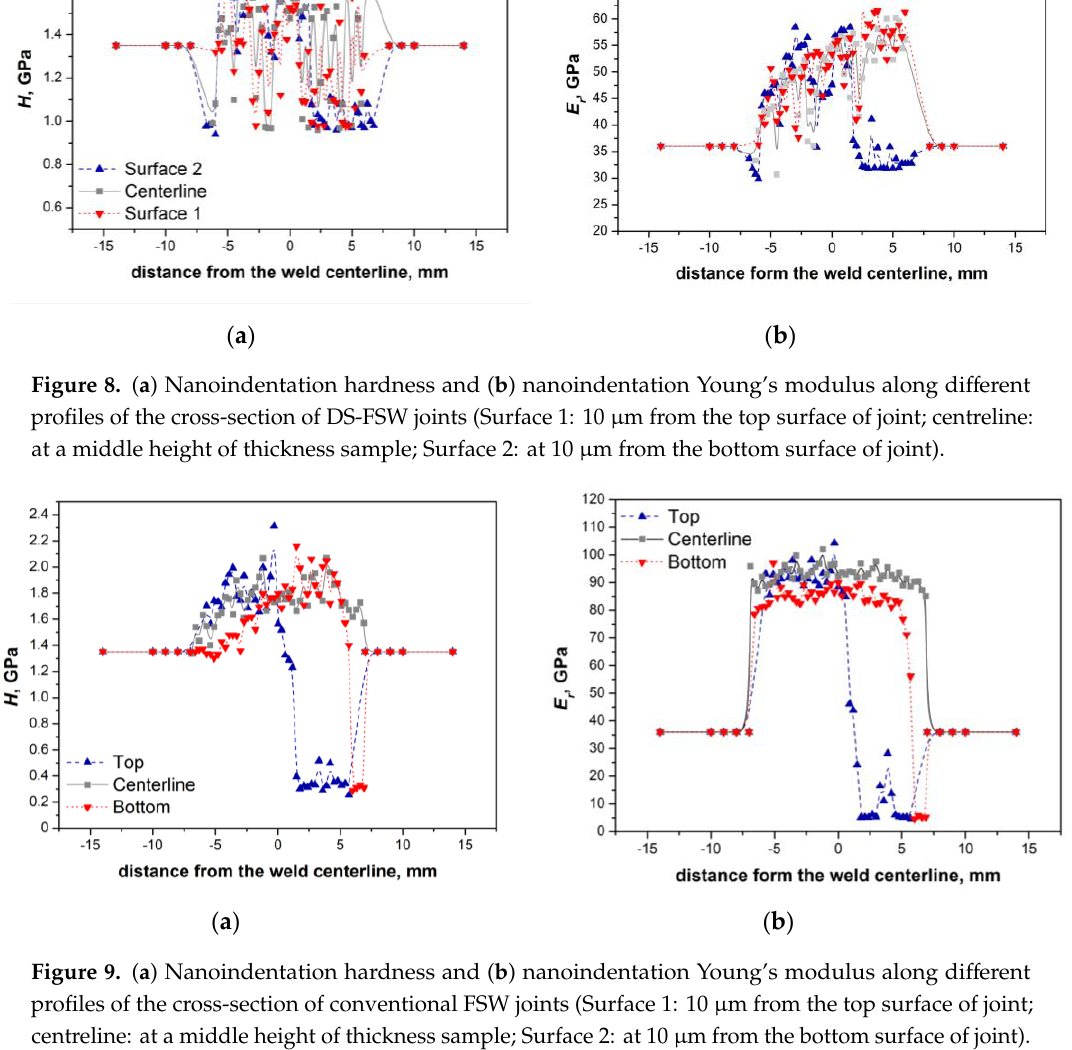
Figure 10. The effect of welding methodology process, and a sample arrangement of welded joints versus base material on forming limit curves. In order to overcome typical FSW defects in 5000 aluminum series alloy joints, such as the oxide layer formation on the butt surface leading to the “kissing-bond” phenomenon and the faint zigzag- line pattern, the RT-type FSW methodology leads were proposed by Cabibbo et al. [18]. The formation of such defects, depending on the tool geometry and shape, and process parameters, significantly affects the mechanical properties of joints [15,77,78].